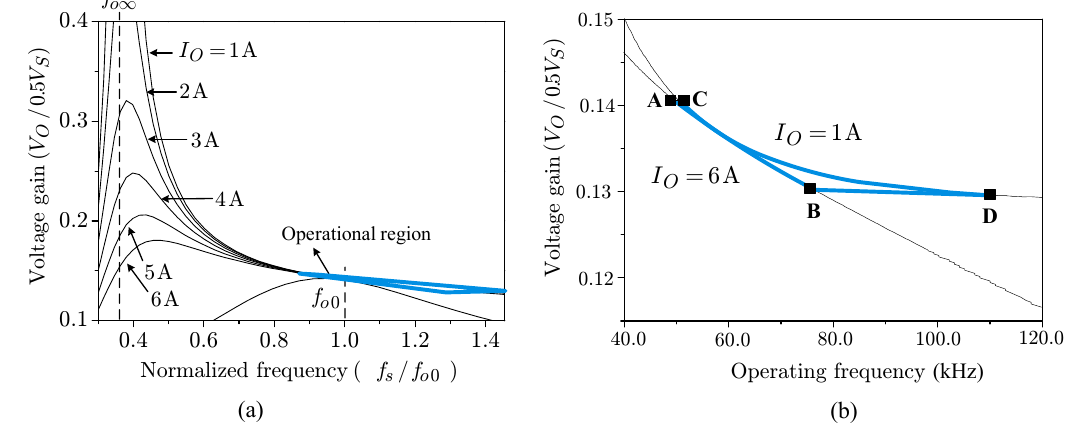
Figure 3. Input-to-output voltage gain curves and operational region of experimental LLC converter. ( a ) Input-to-output voltage gain curves: f ( b ) Expanded view of operational